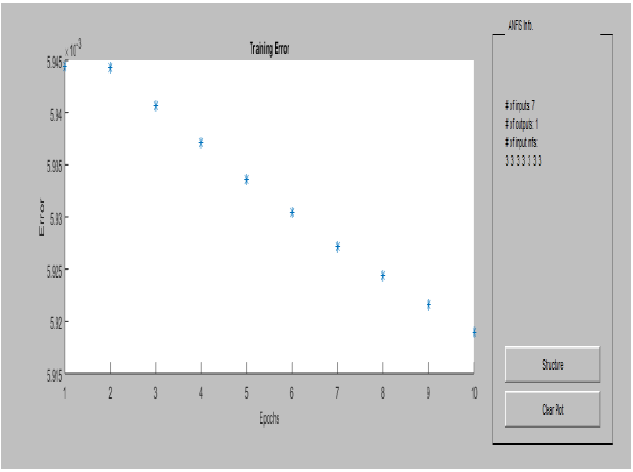
Figure 11. Training error reduced